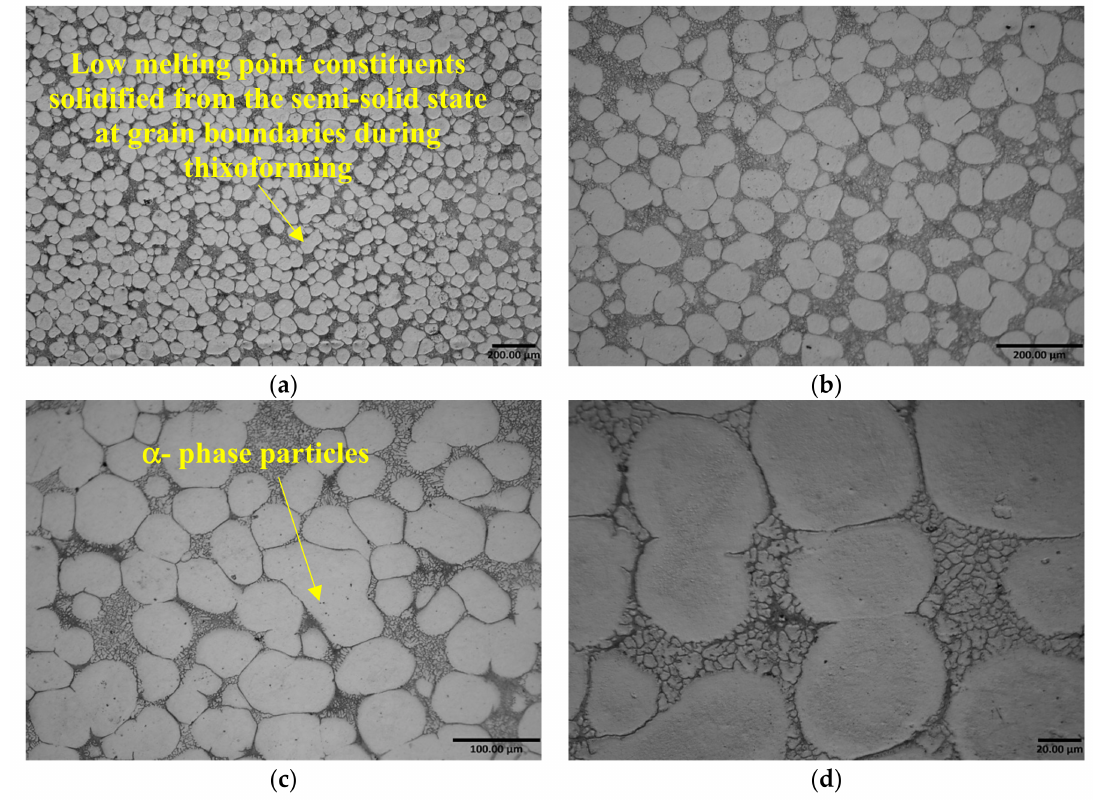
Figure 2. Optical micrographs showing the thixoformed base metal (BM) of 7075 Al Electron Beam (EB) welded plates ( a – d ) with typical near spheroidal microstructure at different